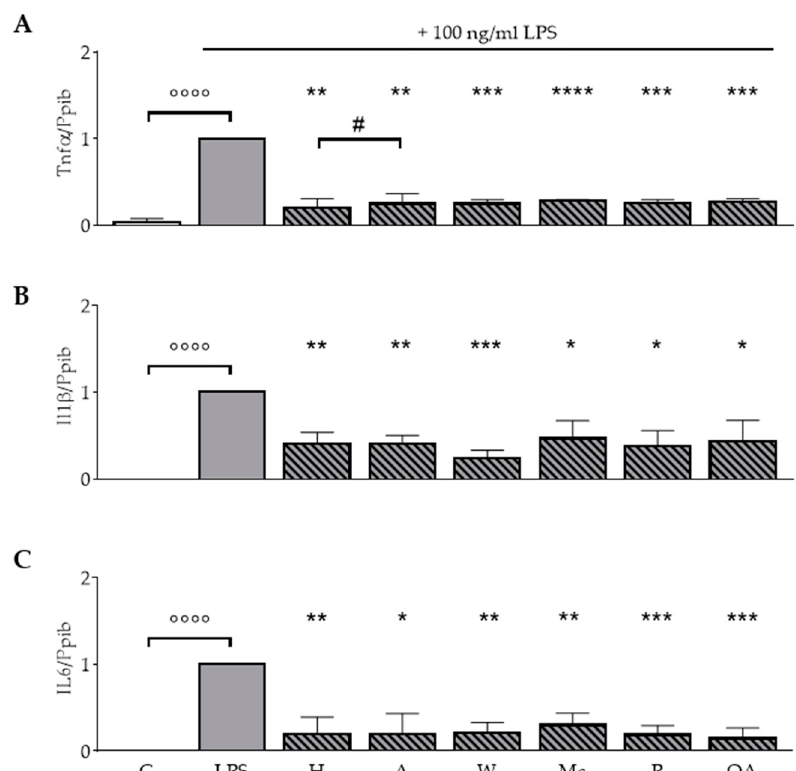
Figure 3. Oily nut extracts (ONE) and oleic acid (OA) strongly block LPS-induced Il1 β , Il6, and Tnf α mRNA expression in RAW264.7 macrophages. RAW264.7 macrophages were incubated as